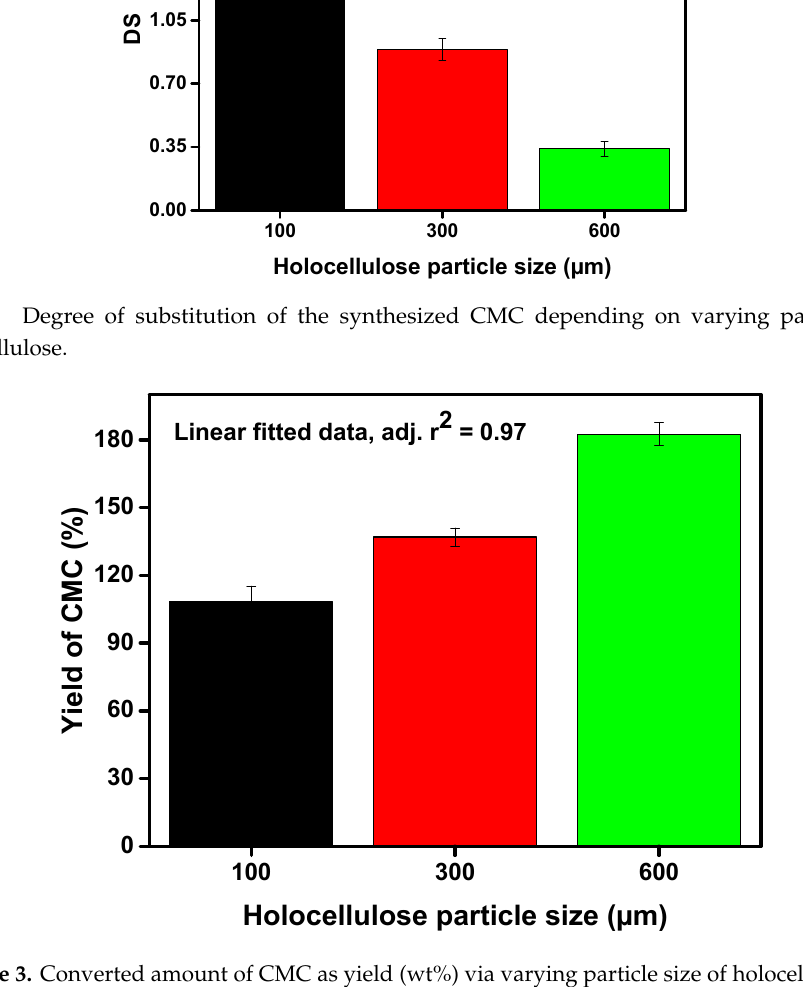
Figure 3. Converted amount of CMC as yield (wt%) via varying particle size of holocellulose.